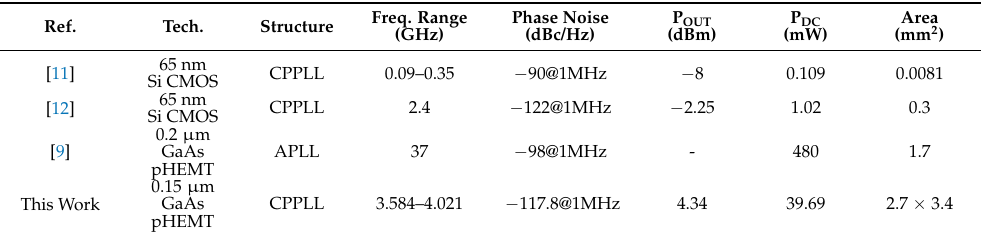
Table 1. Comparison with some previously reported